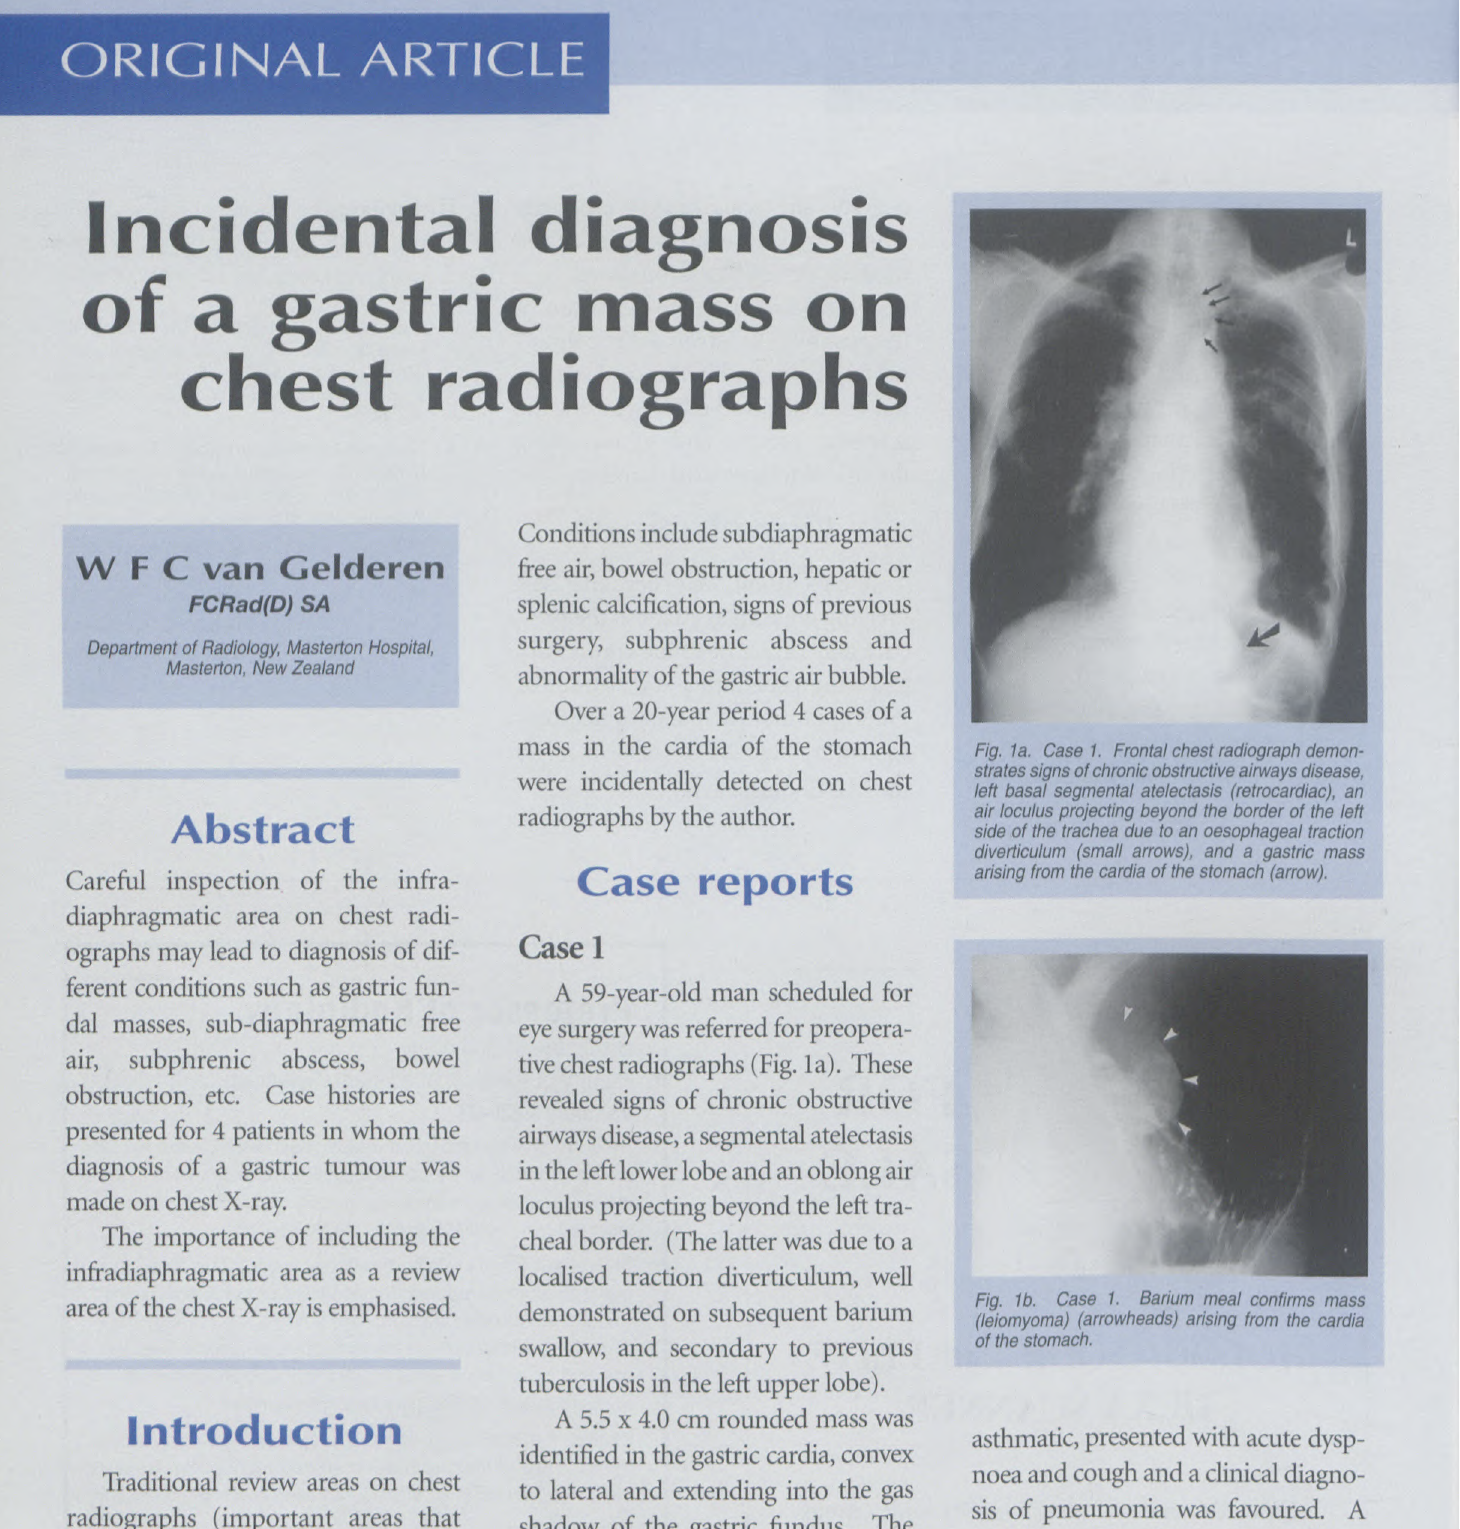
Fig. 1 b. Case 1. Barium meal confirms mass (leiomyoma) (arrowheads) arising from the cardia of the